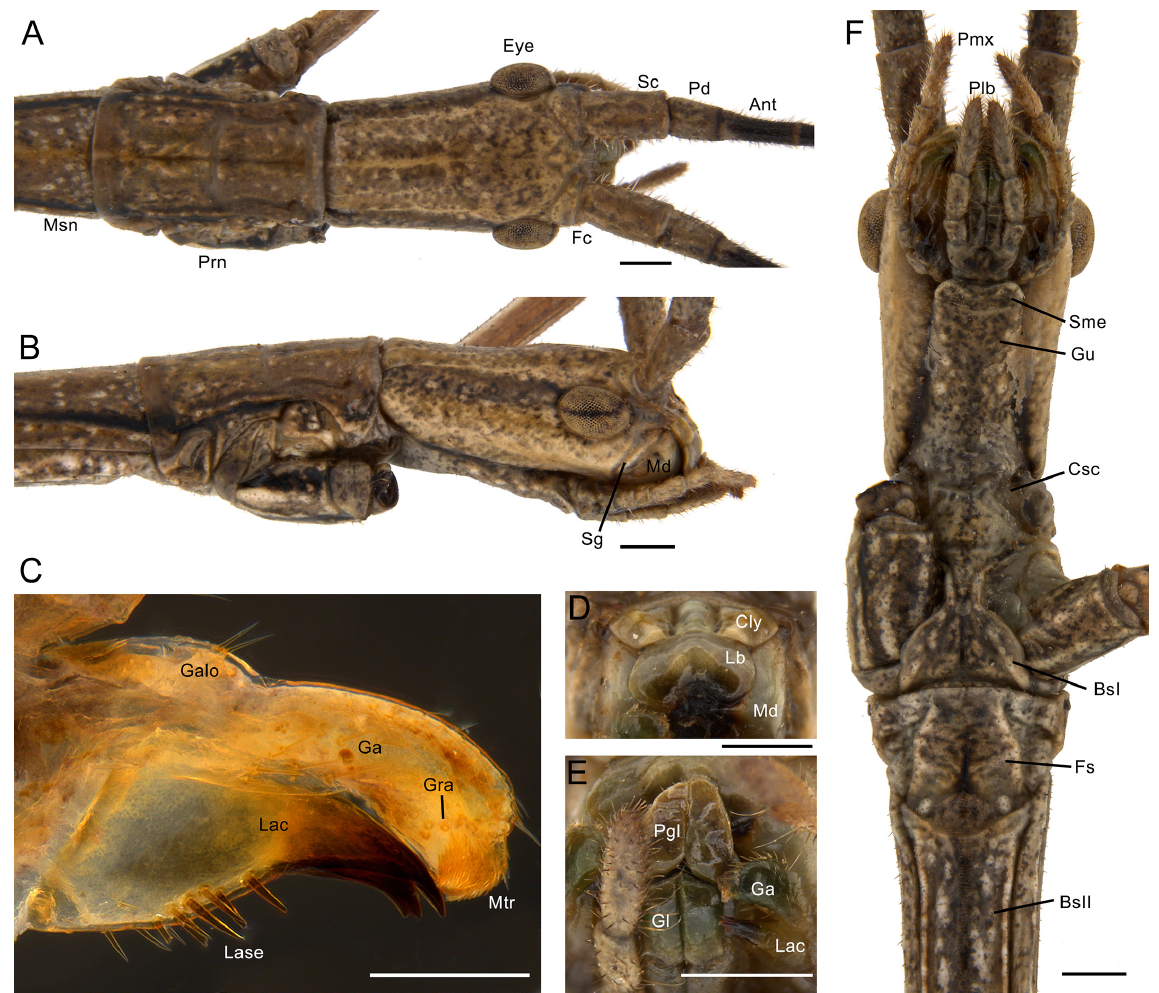
Fig. 38. Arumatia motenata Ghirotto gen. et sp. nov., paratype, ♂ (MZUSP V0602), head and prothorax morphology. A . Head and prothorax in dorsal view. B . Head and prothorax in lateral view. C . Left maxilla in dorsal (internal) view. D . Detail of labrum, anterior view. E . Detail of paraglossa and glossa, antero- ventral view. F . Head and prothorax in ventral view. Abbreviations: Ant = antennomere; BsI-II = pro- and mesothoracic basisterna; Cly = clypeus; Csc = cervical sclerite; Eye = compound eye; Fc = frontal convexity; Fs = prothoracic furcasternite; Ga = galea; Galo = galealobulus; Gl = glossa; Gra = granules; Gu = gula; Lac = lacinia; Lase = lacinial setae; Lb = labrum; Md = mandible; Msn = mesonotum; Mtr = microtrichia; Pd = pedicellus; Pgl = paraglossa; Plb = labial palpus; Pmx = maxillary palpus; Prn = pronotum; Sc = scapus; Sg = subgena; Sme = submentum. Scale bars: A–B, D–F = 0.5 mm; C = 0.2